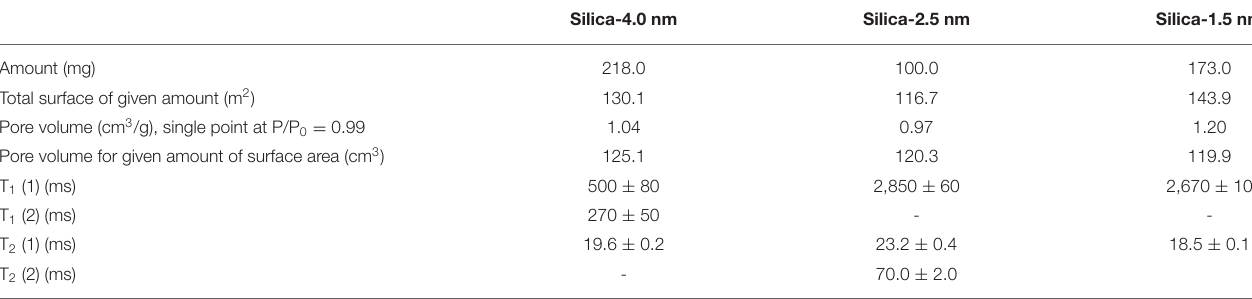
TABLE 2 | T 1 and T 2 values of confined water obtained by keeping pore volumes approximately constant.